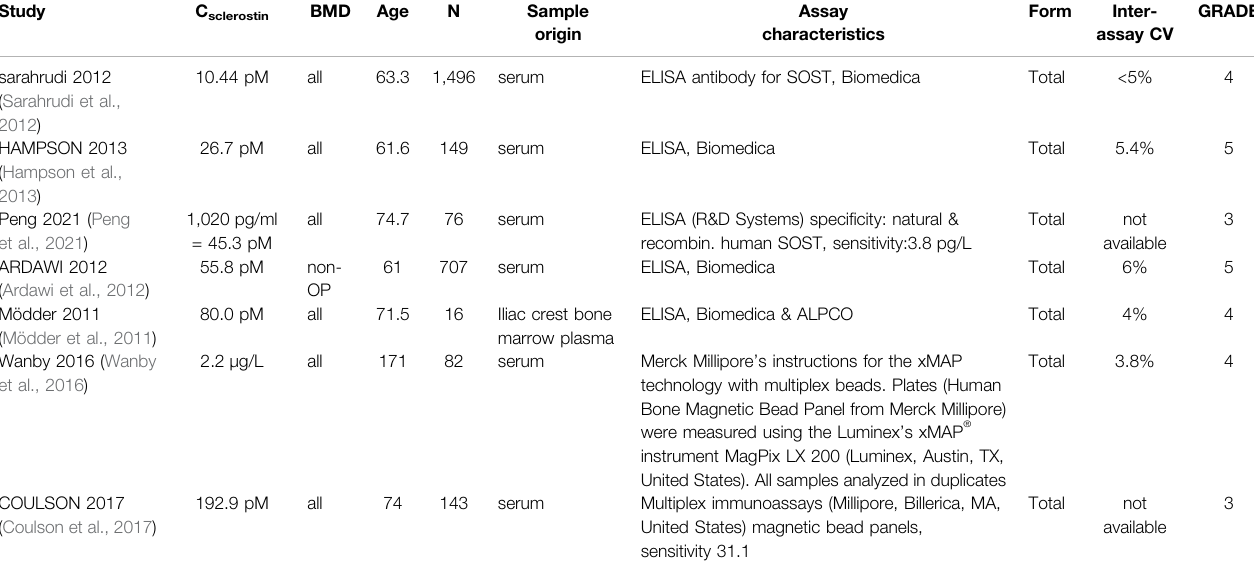
TABLE 7 | Sclerostin concentration measurements in postmenopausal women, in ascending order. Study